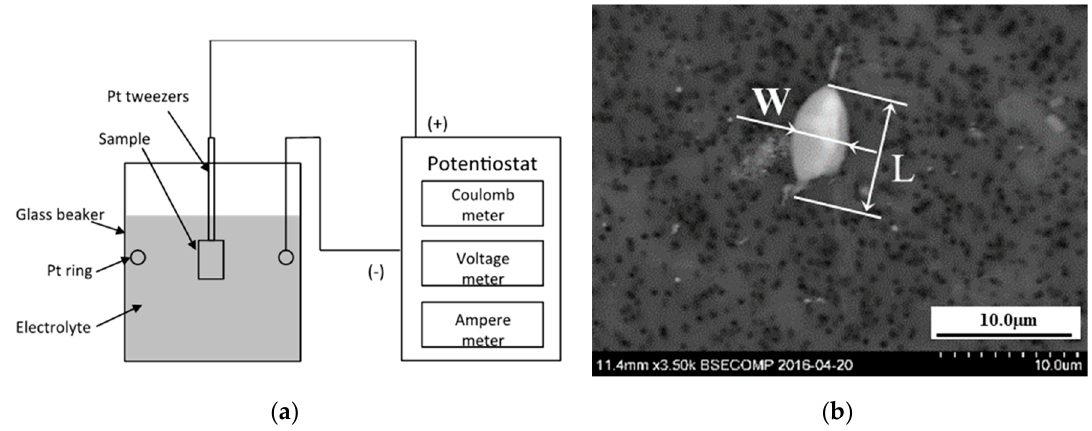
Figure 2. ( a ) Schematic diagram of the equipment used for electrolytic extraction (EE); ( b ) Size measurements of inclusions, where L and W are the length and width of the inclusion.